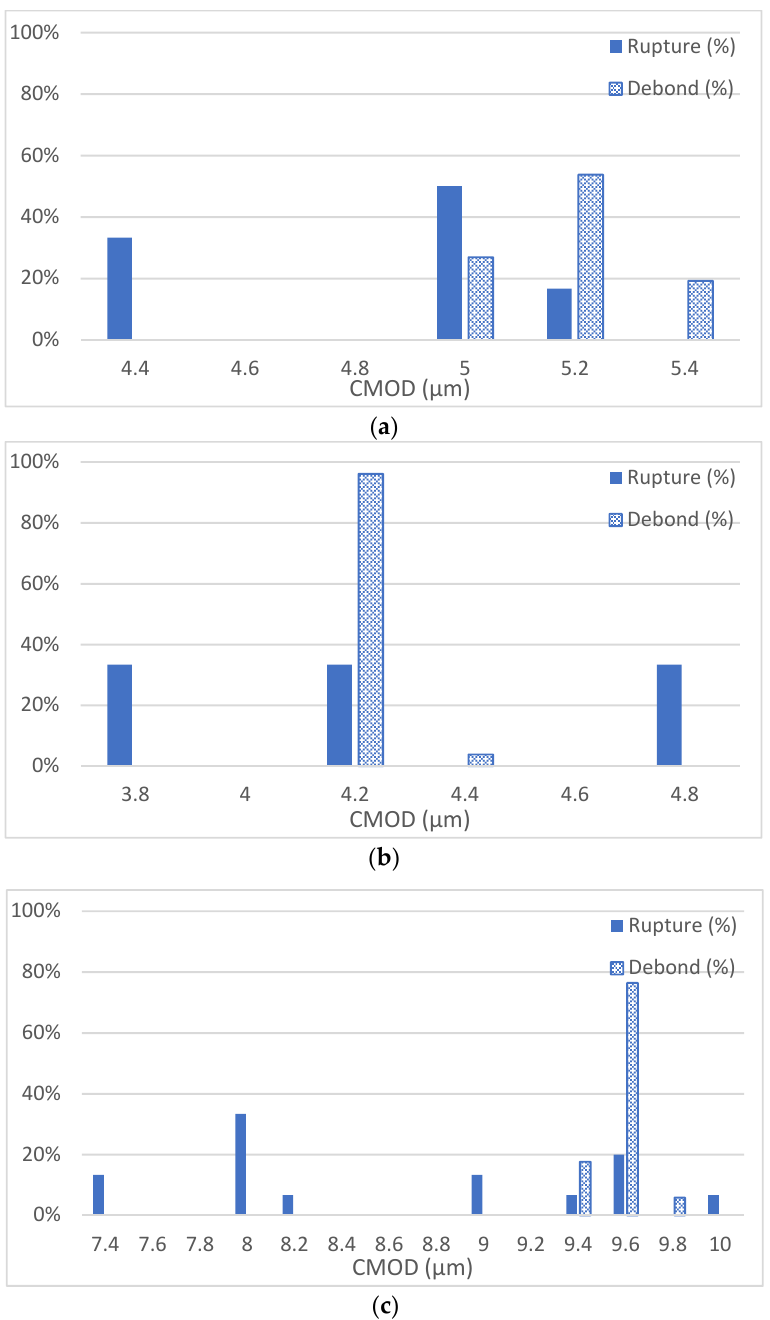
Figure 4. Capsule failure modes: ( a ) rupturing, ( b ) debonding.